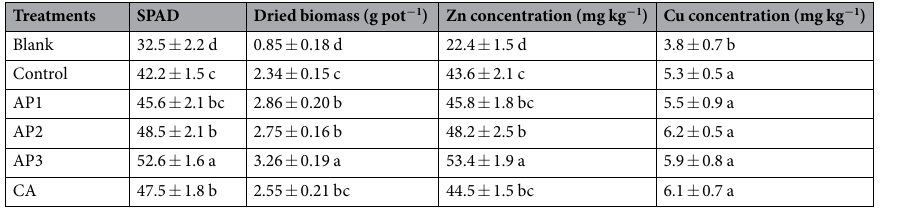
Table 1. Effect of compost addition on the growth of Chinese cabbage in pot experiment. Note: Values indicate mean ± standard deviation based on the samples with four replications. Data in a column with the same letter mean there were no significant differences at p <